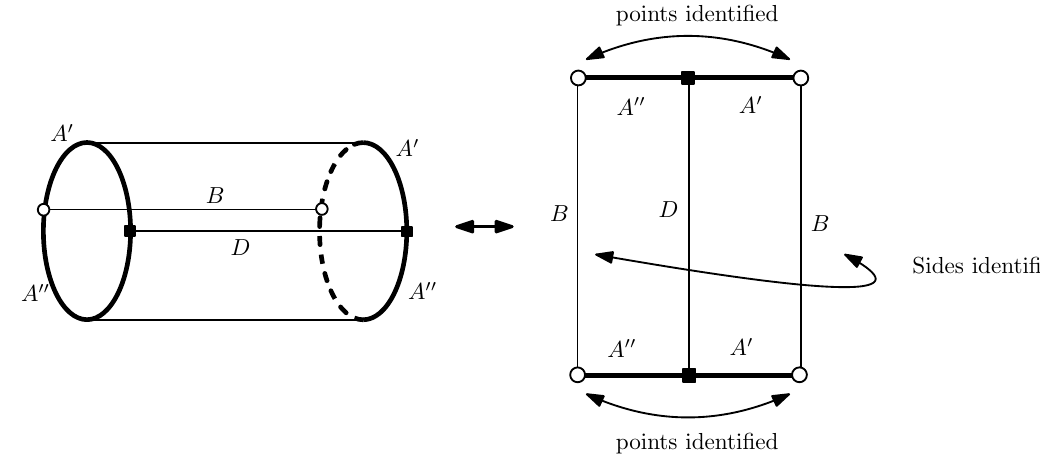
Figure 12. Example of computation of (cid:31) (~(cid:6) g; 0 ) with g = 1. Using the de(cid:12)nition (cid:31) = F (cid:0) E + V we (cid:12)nd (cid:31) (~(cid:6) 1 ; 0 ) = 0, just like for the normal torus. At higher genus, this shows us that the points (white dots) on each side of the re(cid:13)ection axis D must be identi(cid:12)ed in (cid:12)gure 7, while the top and bottom points (black boxes) are not; the B i cycles must also be identi(cid:12)ed, but the A 0 not. This gives the result of eq.